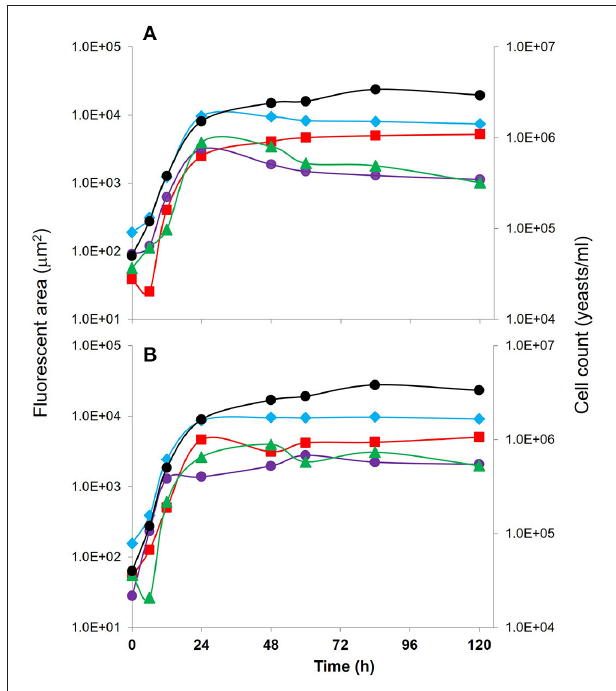
FIGURE 2 | Quantitative growth kinetics measured as total fluorescent areas (from FISH analysis) and as colony plate counts of mixed cultures (Sc:Td:Km) of Sc3Y3, Td1AN9, and Km1Y9 strains for two mixed inocula ratios: (A) 0.1:1:1, and (B) and 1:1:1, fermenting on Agave medium. Symbols: DAPI (all yeasts), Km, Sc, Td, cell count (yeasts/ml). Standard deviation was below 10% for all data.